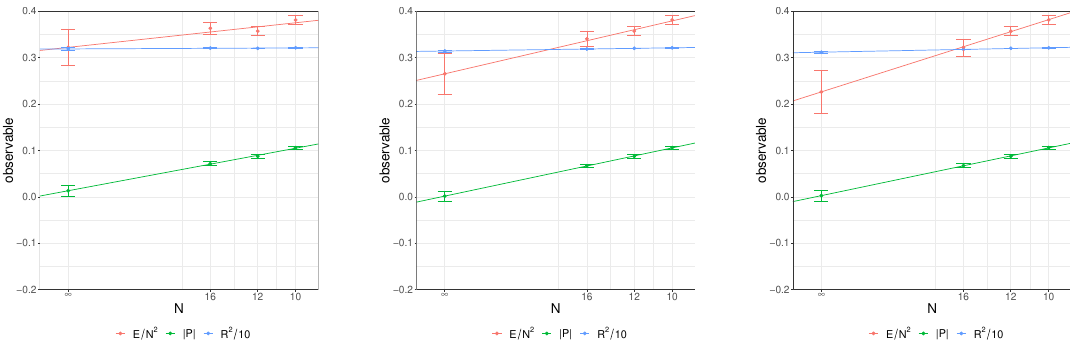
Figure 33. BFSS at T = 0 . 2 , large N extrapolations in the confined phase for L = 30 . Trajectories for L = 30 , N = 16 were discarded if R 2 was greater than a certain cutoff value. From left to right: no cutoff, R 2 ≤ 3 . 23 , R 2 ≤ 3 . 21 . We observe that the large N value of P approaches zero as the cutoff is